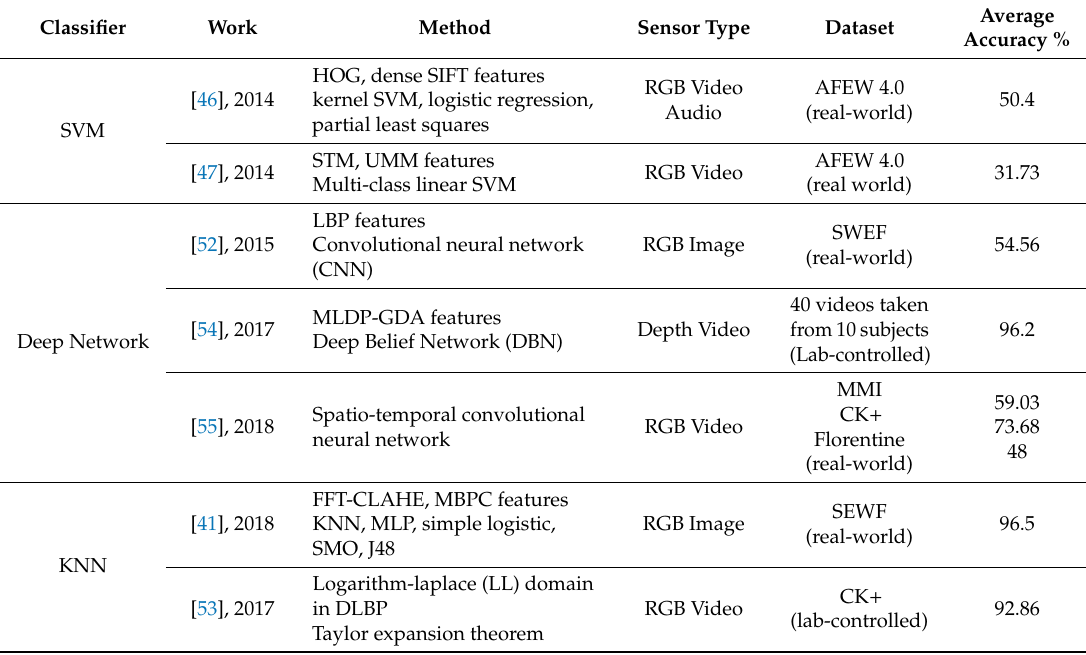
Table 1. Existing FER systems for resolving illumination